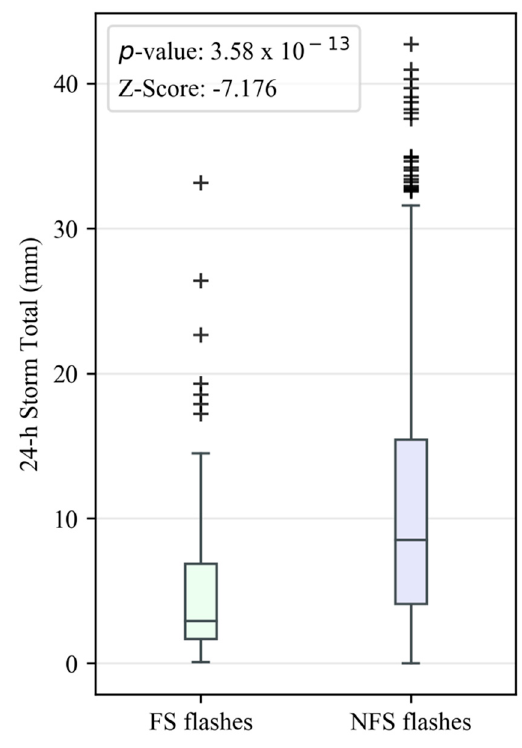
Figure 5. Distributions of 24-h precipitation totals at FS and NFS flash locations.